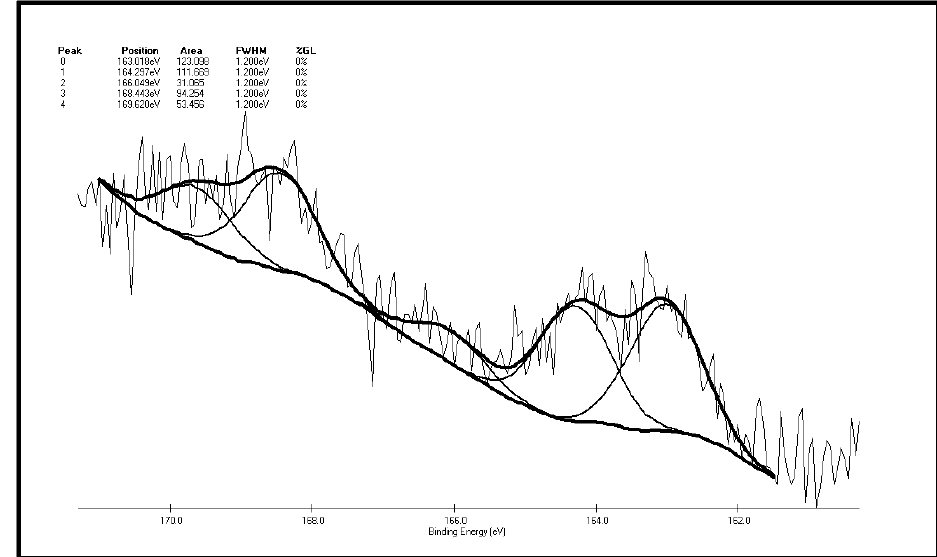
Figure 7. S 2p spectrum of the XF original coal sample.